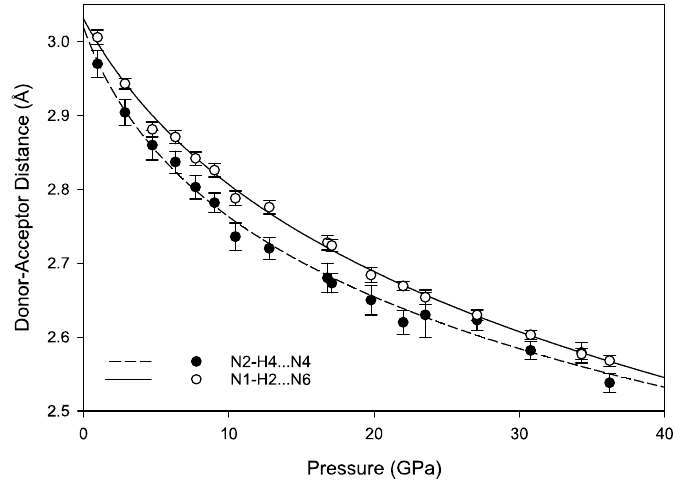
Figure 9. Intra-plane hydrogen bond D···A distance as a function of pressure, fitted with a third-order polynomial function.